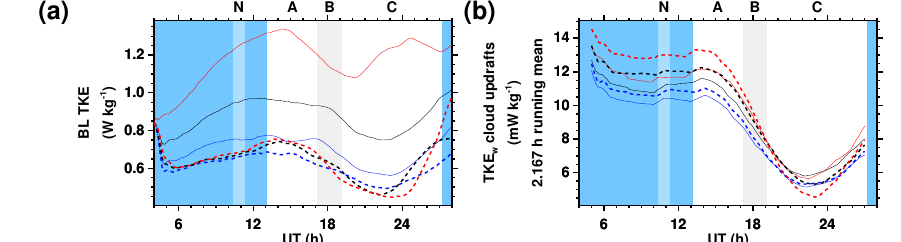
Figure 14. Buoyancy- and shear-driven dynamics. Boundary layer TKE (a) and the vertical TKE component (TKE w ) in cloud updrafts (b) are given per total boundary layer air mass. Time series from simulations L − + 0 L buoy (blue), L buoy (black), L buoy (red), dashed curves. A low-pass (running mean) filter was applied where indicated to reduce